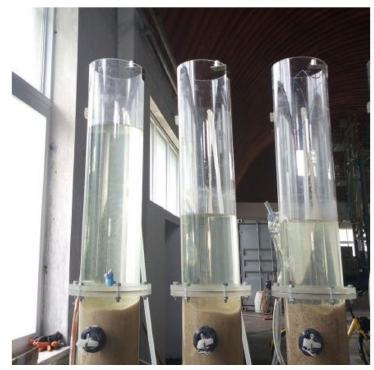
Figure 4. Photos of equipment in operation; SSF1 # , SSF2 # , and SSF3 # (from left to right). Clogging became evident in SSF1 #